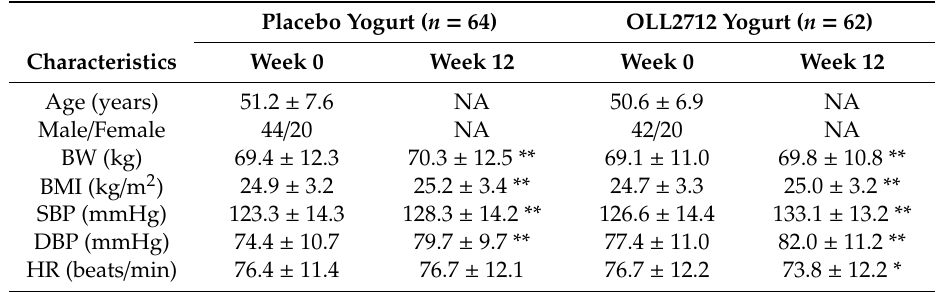
Table 1. Baseline characteristics of study participants and changes in these characteristics after the 12-week intervention. Placebo Yogurt ( n = 64) OLL2712 Yogurt ( n = 62)